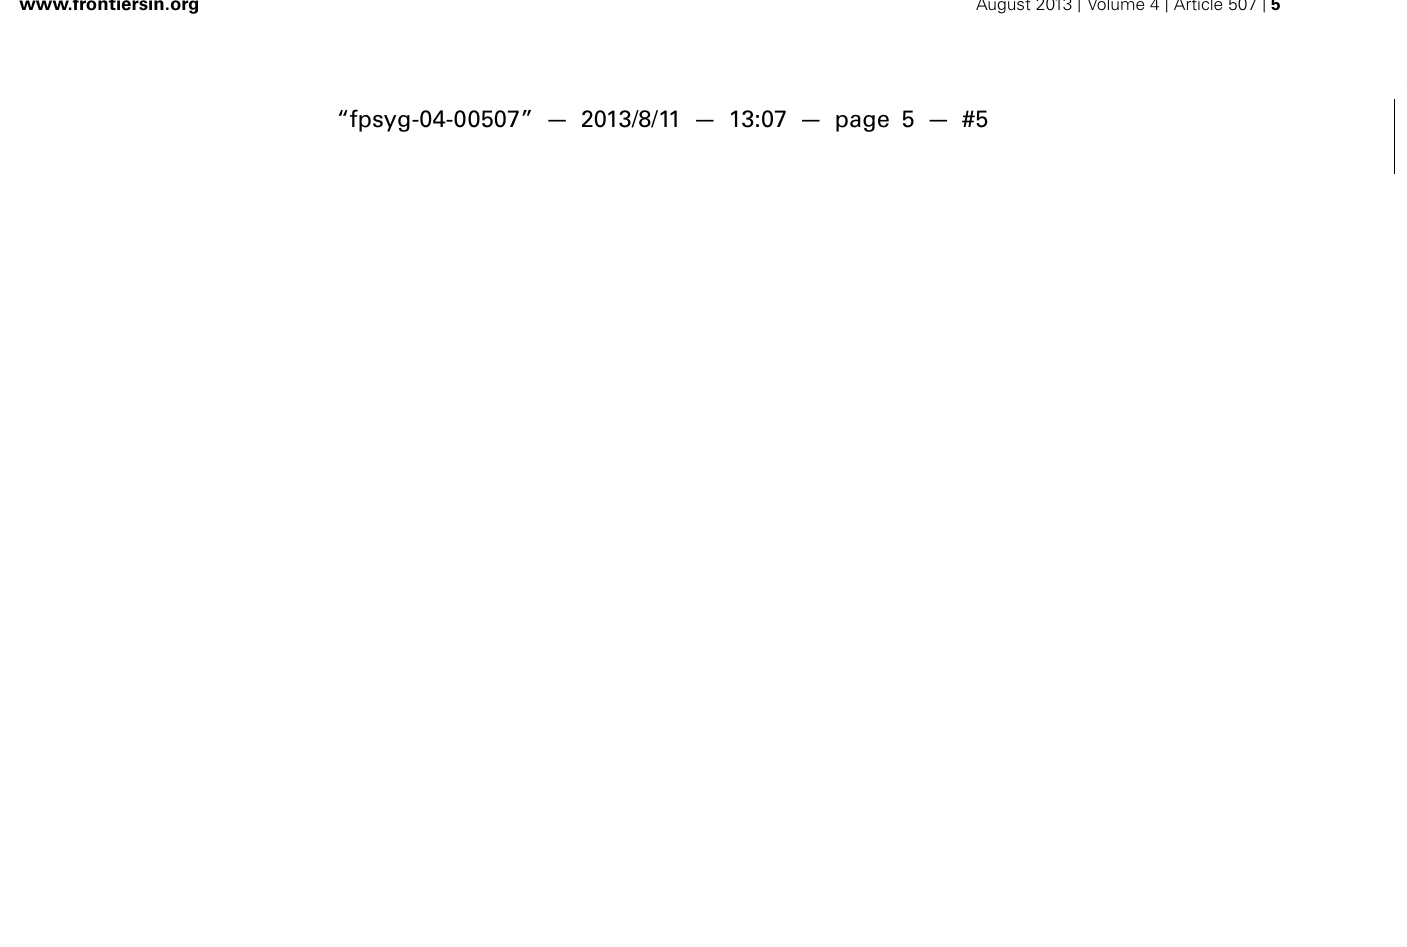
( F (2, 130) = 0.8, p = 0.45) was not significant, nor were any of the other interactions ( F < 1.54, p > 0.20 in each